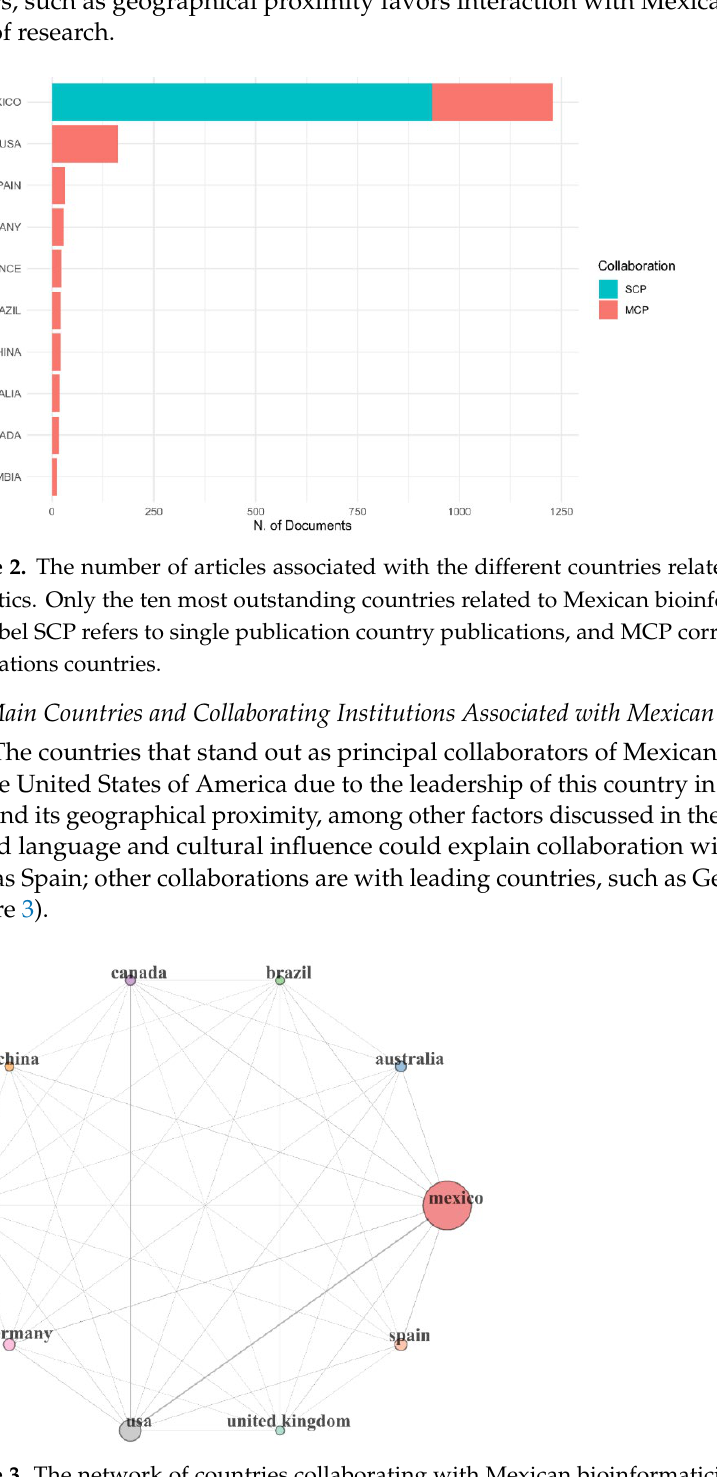
Figure 3. The network of countries collaborating with Mexican bioinformaticians. The area of the circle reflects the proportion of articles where each country collaborates in the literature associated with Mexican bioinformatics.